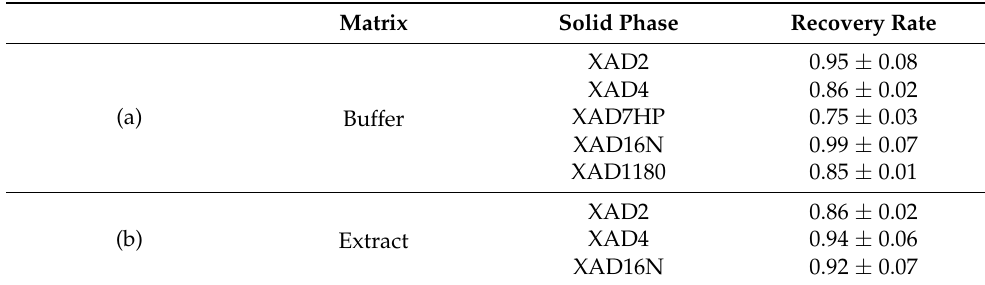
Table 1. Screening of the adsorbents for solid phase extraction of 4-vinylguaiacol. Recovery rates were calculated by comparing the concentrations of elution fractions and the starting solution. Bis-